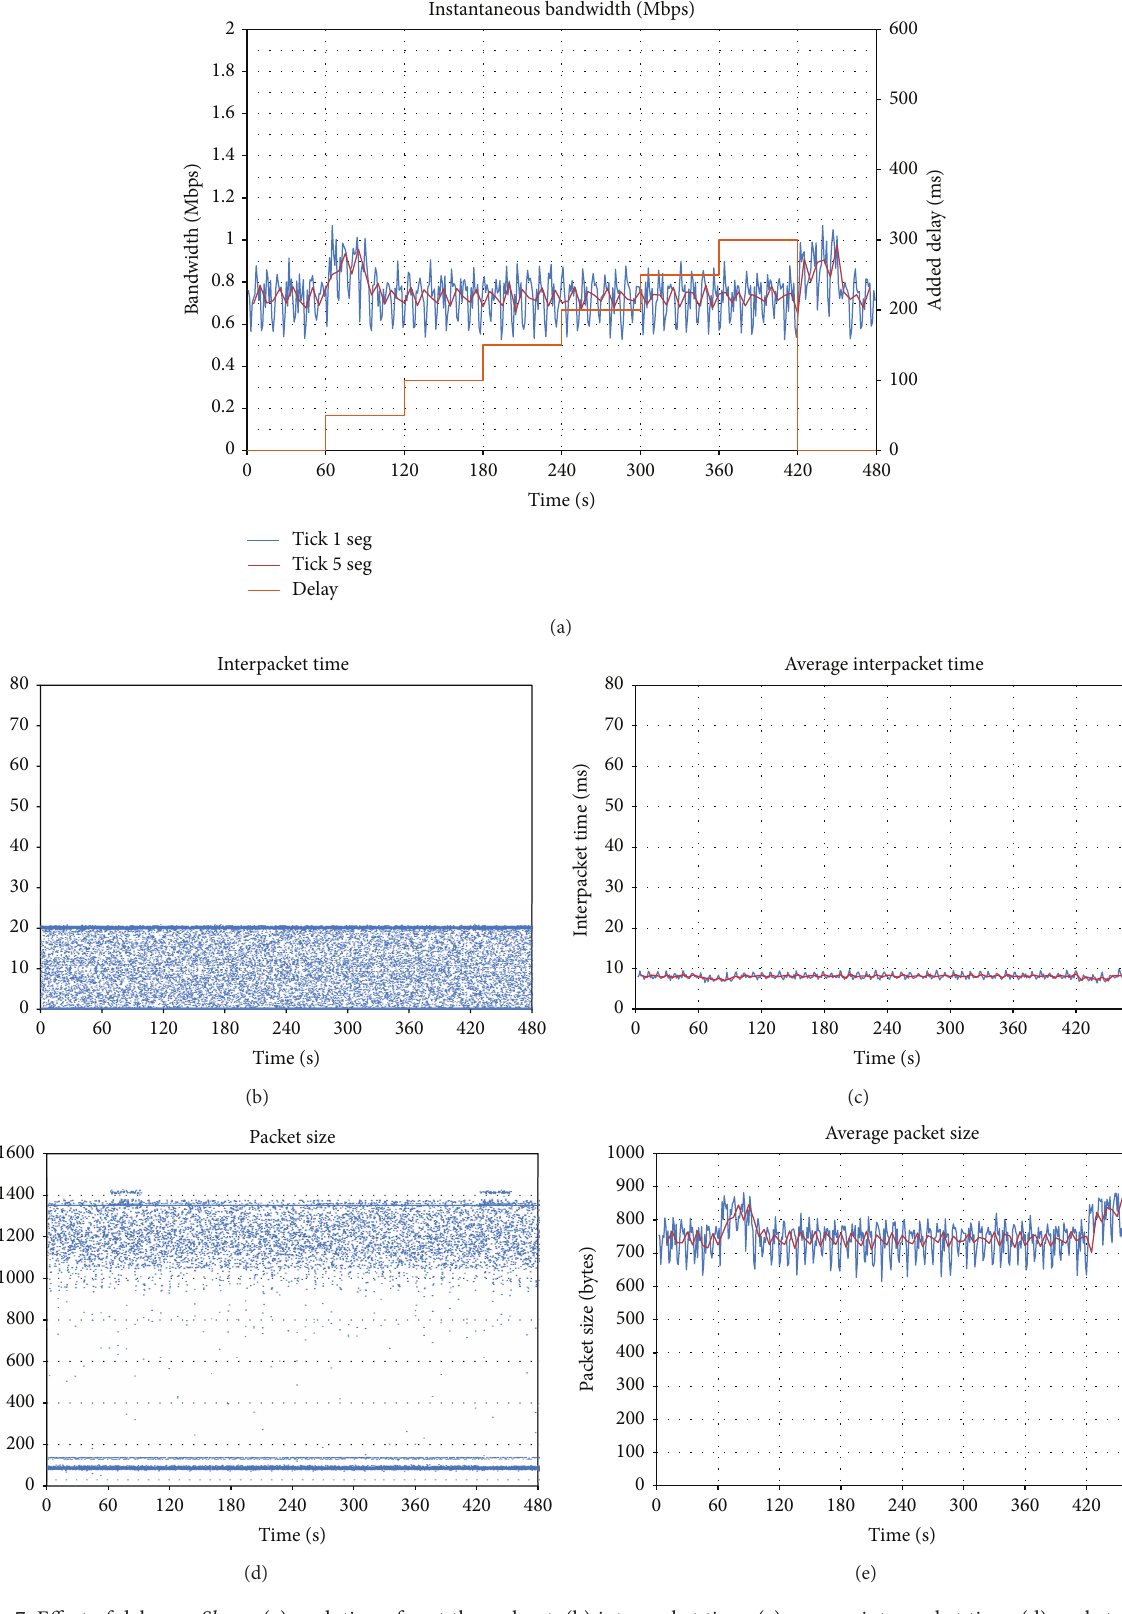
Figure 7: Effect of delay on Skype : (a) evolution of sent throughput; (b) interpacket time; (c) average interpacket time; (d) packet size; (e) average packet